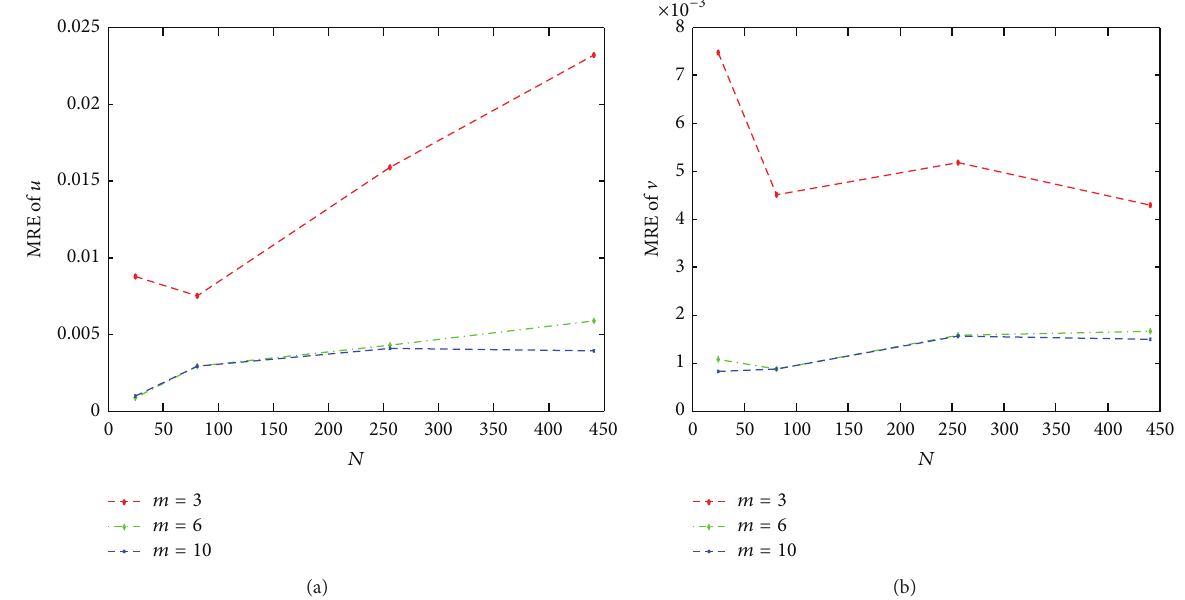
Figure 1: Both errors of 𝑢 and V against the number of nodal points: 𝑚 = 10 , 𝑡 = 1 , and Δ𝑡 = 0.1 . (a) MRE of 𝑢 ; (b) MRE of V .